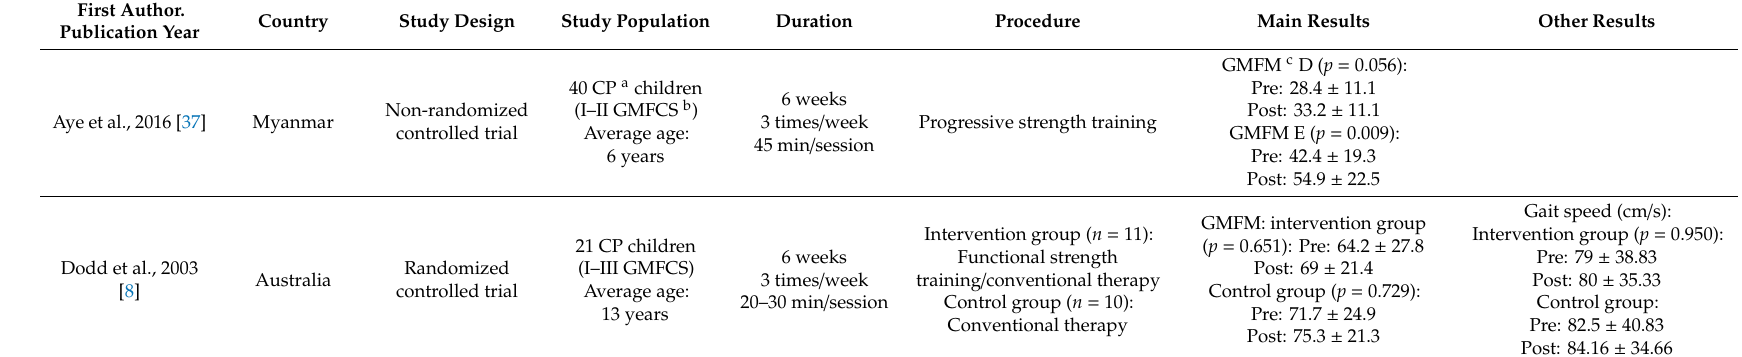
Table 2. Characteristics of included